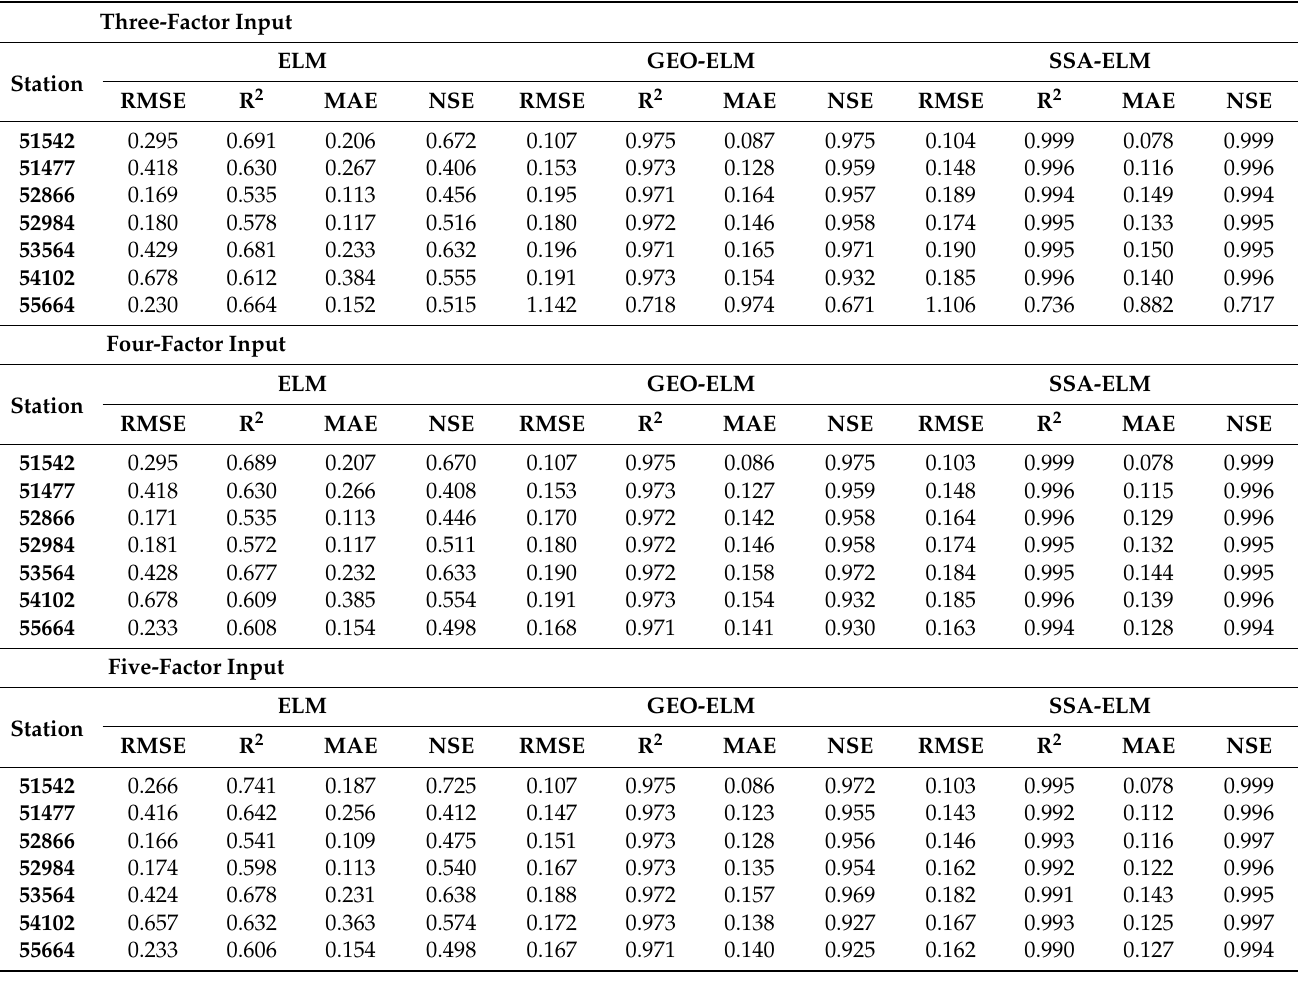
Table 2. Statistical values of the three ET O models with different input